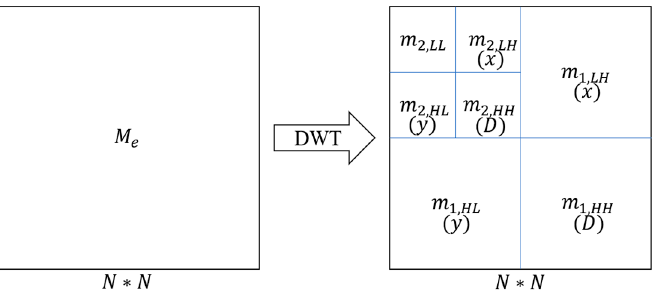
Figure 4. Diagram of second-order wavelet decomposition on M e . The left side is the image matrix for decomposition, and the right side shows the decomposed matrices. 𝑁 is the size of the image matrix. 𝑁 = 2048 in this investigation.